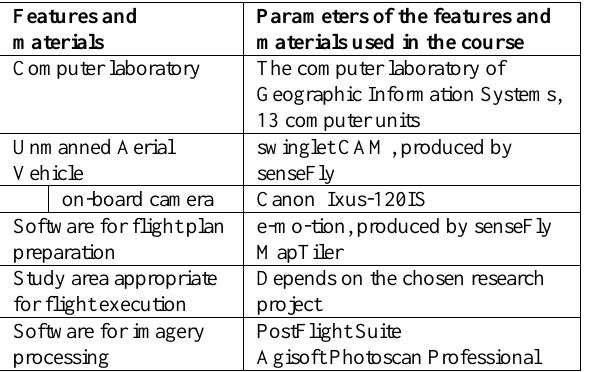
Table 1. Features and materials used in the teaching process for the course at University of Wroclaw